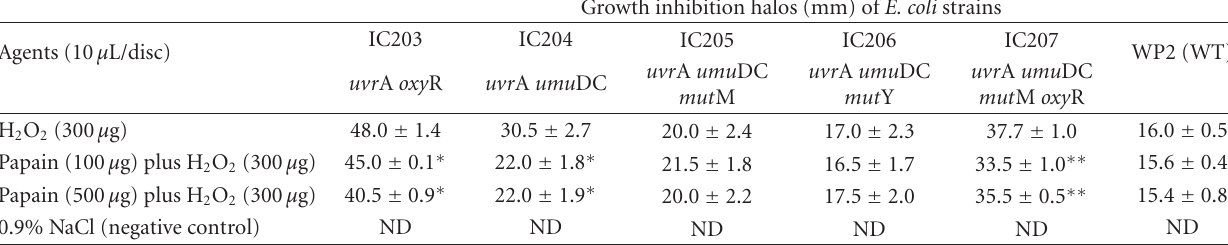
Figure 1: Analysis of plasmid pUC 9.1 DNA strand breaks after treatment with papain. Aliquots of pUC 9.1 plasmid DNA (200 ng) were incubated with di ff erent concentrations of papain for 40 minutes at 25 ◦ C. Each sample was mixed with loading bu ff er and submitted to 0.8% agarose gel electrophoresis. The assay was repeated, at least three times. Densitometric measures were obtained from gel through Gel Pro Analyzer 3.0 software. Lanes: (1) negative control (Milli-Q water); (2) positive control (H 2 O 2 10 mM); (3) 10 μ g; (4) 25 μ g; (5) 50 μ g; (6) 100 μ g; (7) 250 μ g; (8) 500 μ g of papain. Table 2: Inhibition halos (mm) of the E. coli strains after treatment with di ff erent papain concentrations mixed with hydrogen peroxide. Aliquots (100 μ L) of exponentially growing cultures of E. coli were mixed with 3mL top agar (44–46 ◦ C) and spread on LB plates supplemented with antibiotic (ampicillin or chloramphenicol, according to the strain resistance). After 15 minutes, paper discs (5mm diameter) containing di ff erent amounts of the papain (100 or 500 μ g/disc) mixed or not with H 2 O 2 (300 μ g/disc) were placed in the center of the plates. After 24-hour incubation at 37 ◦ C the inhibition halos around the disc were measured. Values are the mean of 3 independent experiments with standard deviations not exceeding 15% (mean ± SD). 5% significance level was adopted to compare data. Growth inhibition halos (mm) of E. coli